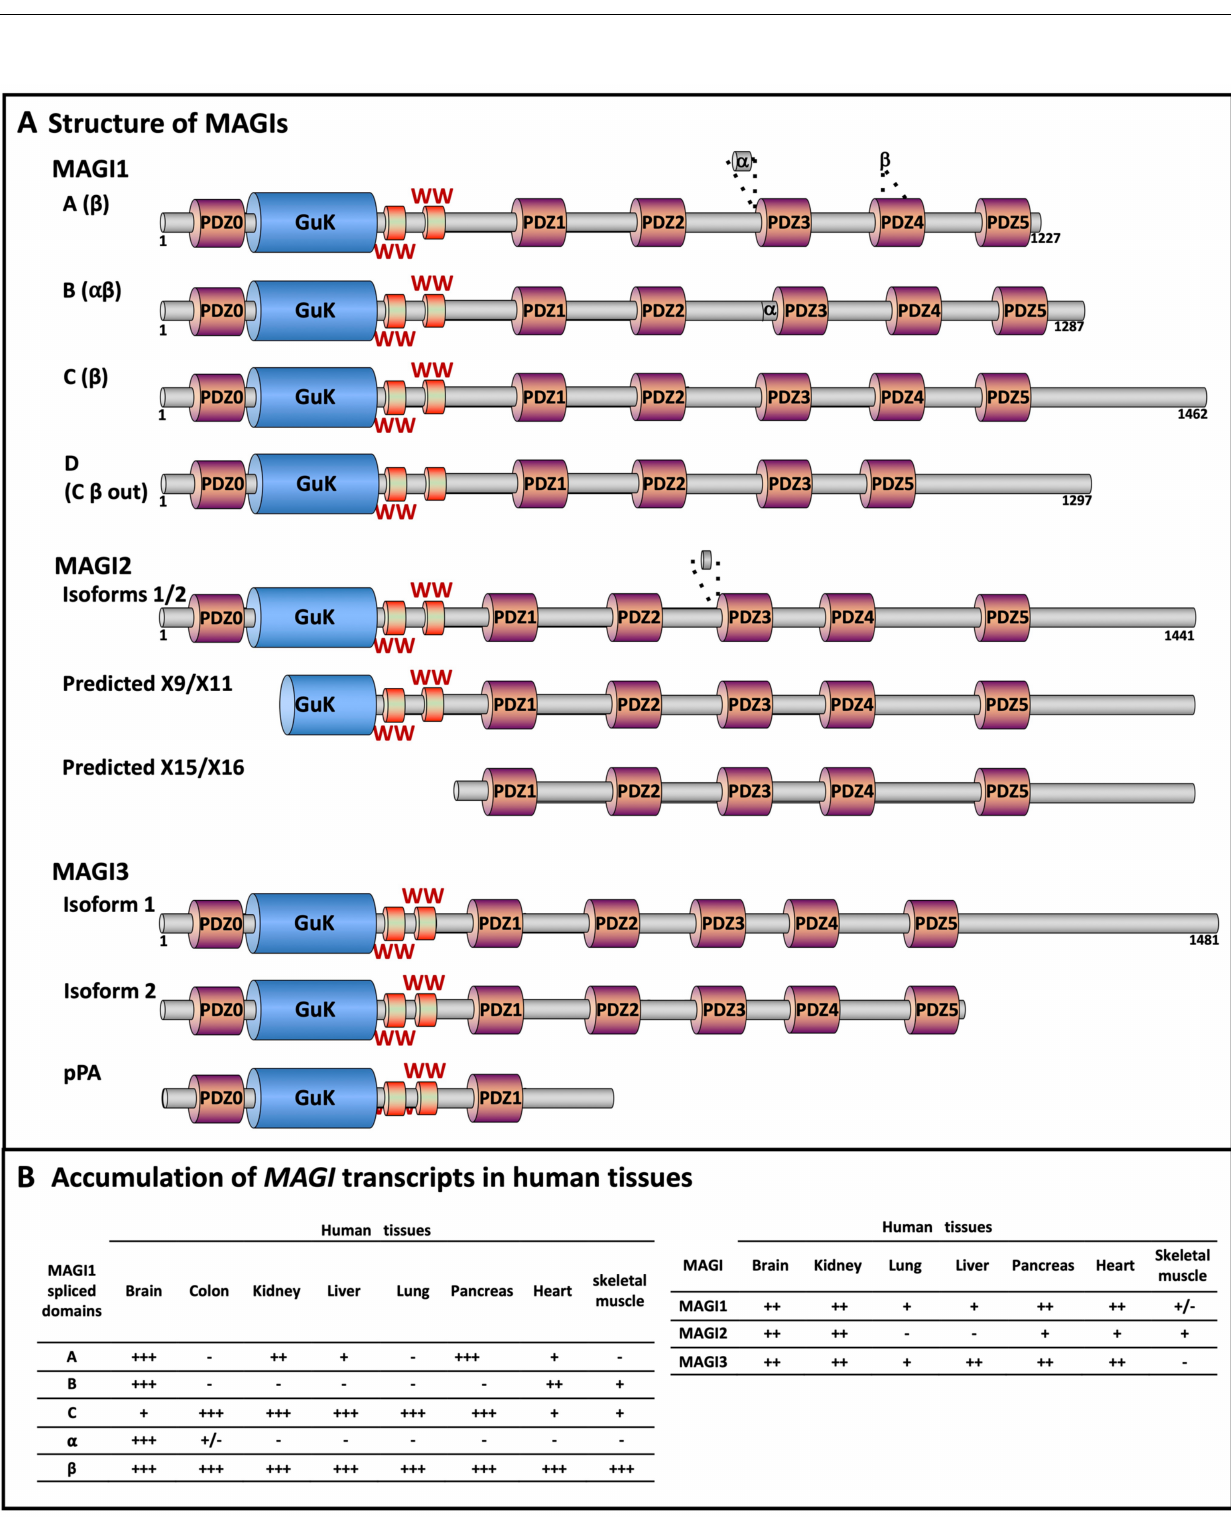
Figure 1. Primary structure of MAGI scaffolding molecules. ( A ) MAGI1, 2, and 3 are comprised of 6 PDZ domains, 2 WW domains, and 1 GUK domain. MAGI transcripts are subjected to posttranscriptional modifications leading to the emergence of several variants. PDZ: PDZ (PSD95, DLG1, and ZO1) domain, numbered from 0 to 5; GuK: guanylate kinase domain; WW: WW domain (also termed rsp5-domain or WWP repeating motif). MAGI1. The isoforms MAGI1A, B, and C